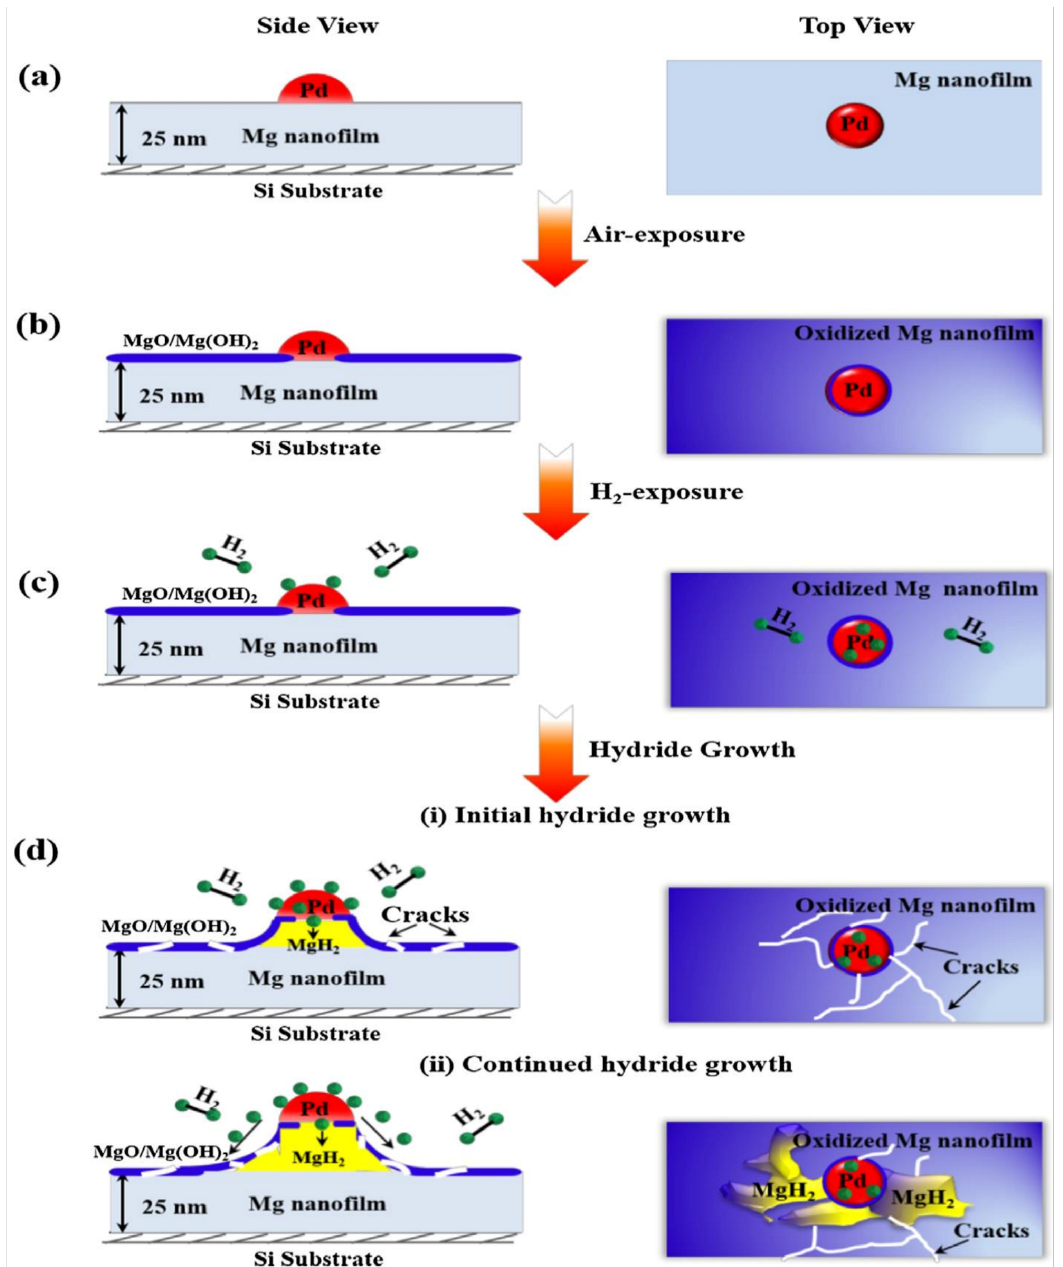
Figure 23. Schematic representation of the steps involved in the formation of localized MgH 2 nanodomains from the hydrogenation of Mg nanofilms catalyzed by Pd NPs. ( a ) Deposition of size-selected Pd NPs on a pristine Mg nanofilm. ( b ) Samples deliberately air-exposed before hydro- genation, leading to the formation of a very thin protective MgO/Mg(OH) 2 layer on the surface of the film. ( c ) Exposure of the sample to hydrogen, leading to dissociation of the hydrogen molecule to atoms on the Pd NP surface. ( d ) (i) Atomic hydrogen diffuses through the Pd NPs and reacts with the Mg nanofilm, forming MgH 2 and surface protrusions under the Pd NPs; ii) these localized protrusions rupture the surrounding MgO/Mg(OH) 2 layer, permitting hydrogen atoms to spill over the Pd NPs and tunnel through the cracks to react with the underlying fresh Mg nanofilm. ( a – d ) Reproduced with permission [53]. Copyright 2016,